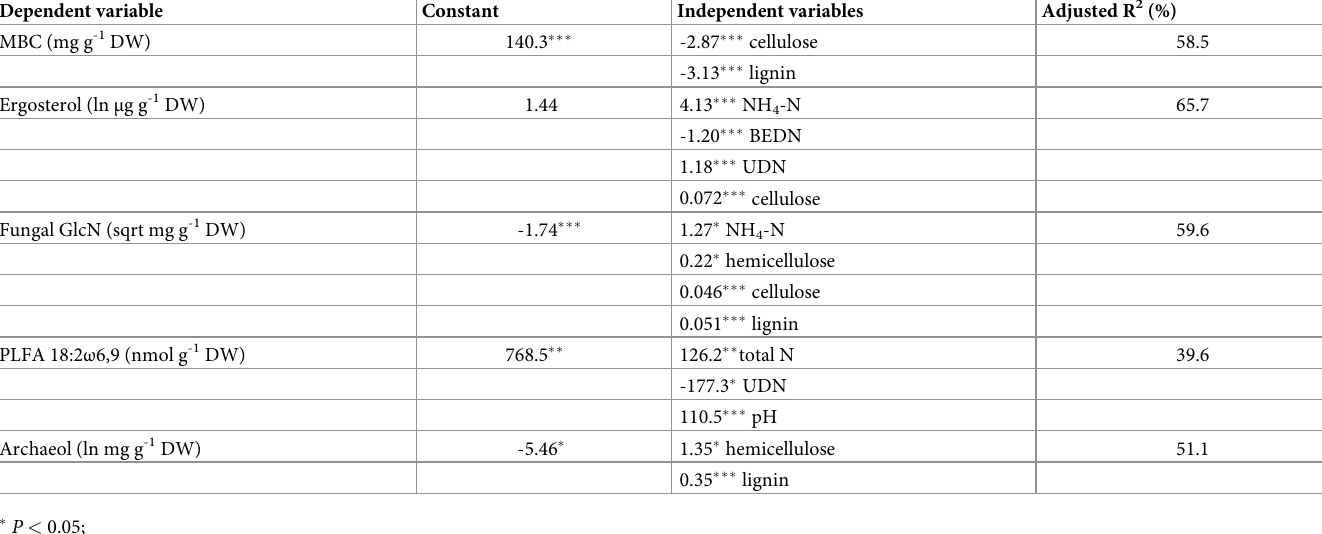
Table 6. Multiple linear relationships between microbial biomass C (MBC), ergosterol, fungal glucosamine (GlcN), the fungal phospholipid fatty acid (PLFA) 18:2 ω 6,9, and archaeol as dependent variables and the chemical faeces properties shown in Table 2 as independent variables; constant is the intercept with y- axis; ergosterol and hemicellulose were ln transformed, whereas fungal GlcN was square-root transformed; BEDN = bacterial and endogenous debris N; UDN = undigested dietary N.